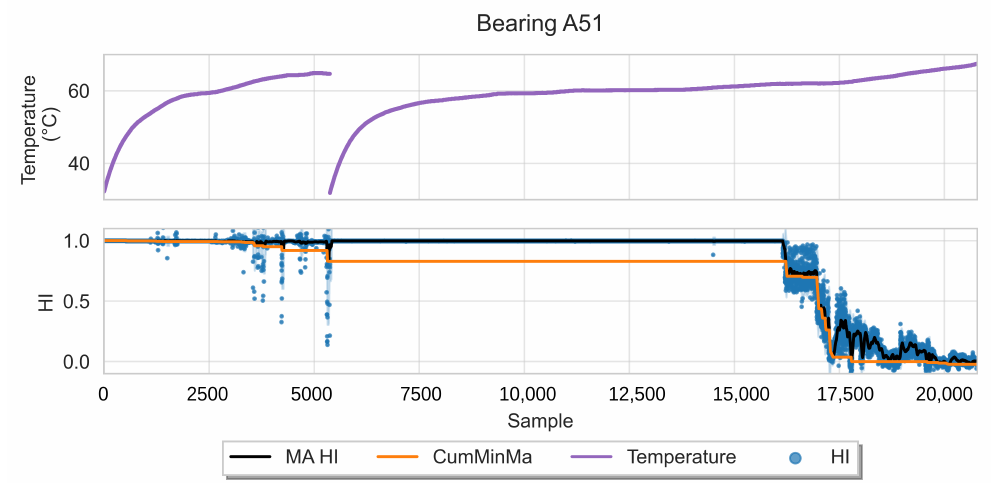
Figure 9. Temperature and HI of bearing A51 of the SMLL dataset. A drop in the HI is detected before the machine is stopped. After the machine is restarted, the HI seems to have recovered.